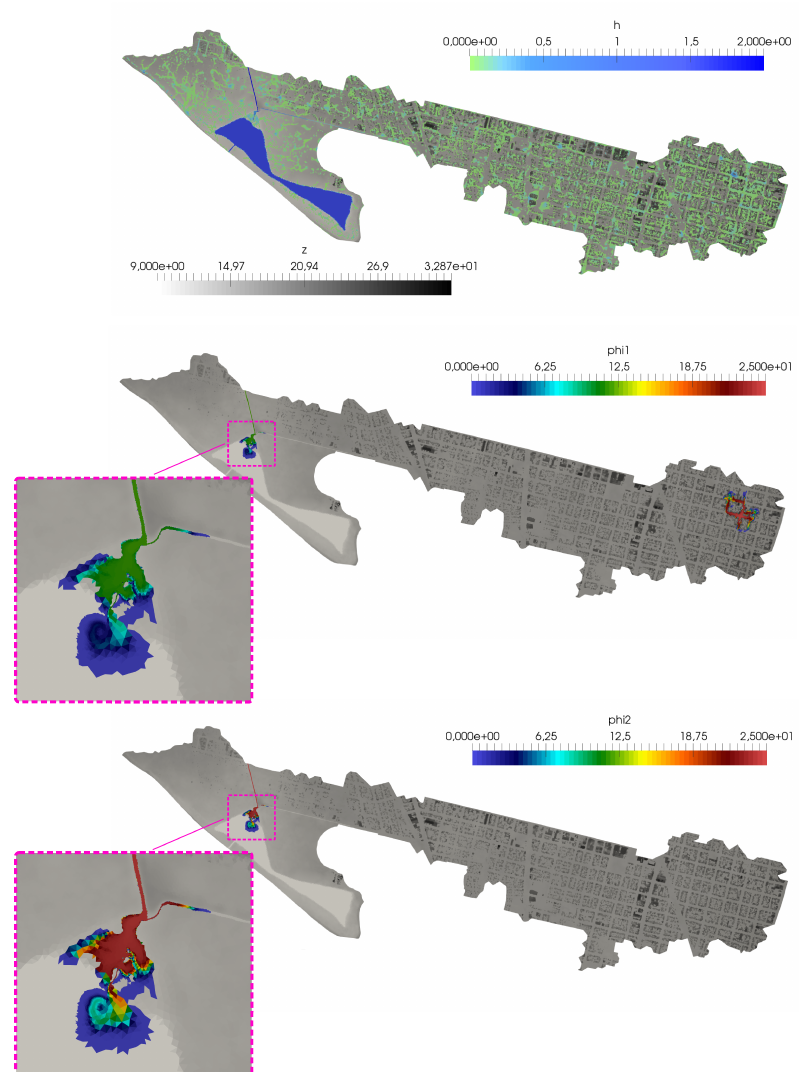
Figure 18. Case 3: Surface water depth h ( upper ) and pollutant concentration for both solutes φ 1 ( center ) and φ 2 ( lower ) at t = 1.5 h.